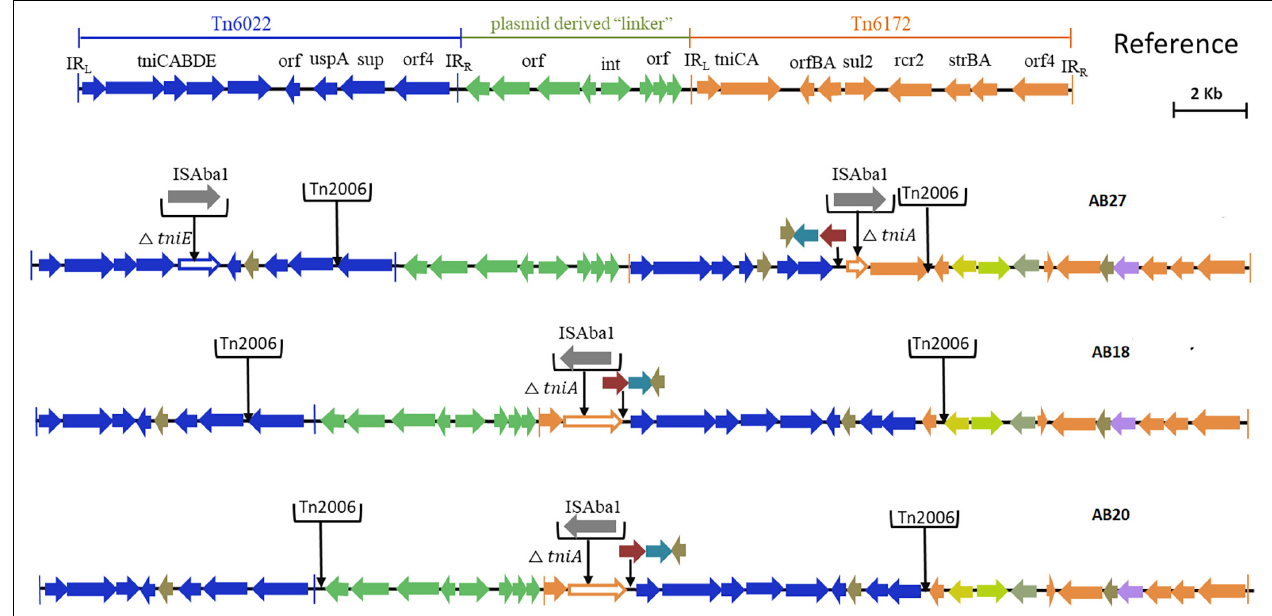
FIGURE 4 | Structures of variants of AbGRI resistance island identified in this study. The typical AbGRI1 structure with an intact “Tn 6022 -linker-Tn 6172 ” backbone is shown as a reference. The Tn 6022 or Tn 6022 -derived part is shown in blue, the Tn 6172 part or its partial segments are shown in orange, and the linker region is shown in green. The black arrows shown downward indicate the insertion of insertion sequence (IS) element or transposon or additional genes.